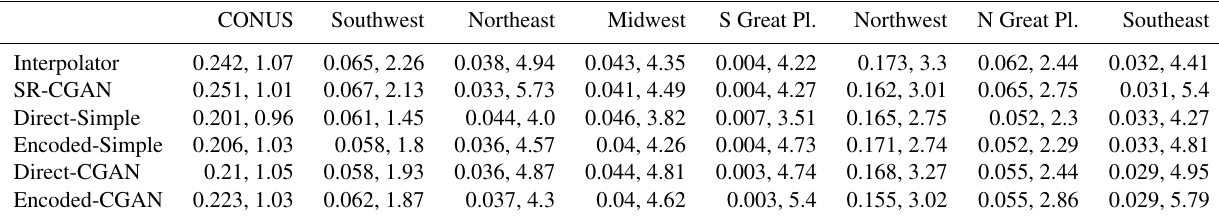
Table 2. MSEs (mm/3h), calculated across all grid cells over the entire CONUS and seven subregions (Eq. 2), at the 50th and 99th percentiles picked from all time steps. The MSEs of the CGAN models are not necessarily smaller than those of the Simple models, especially for heavier precipitation, which has larger MSEs. S Great Pl. N Great